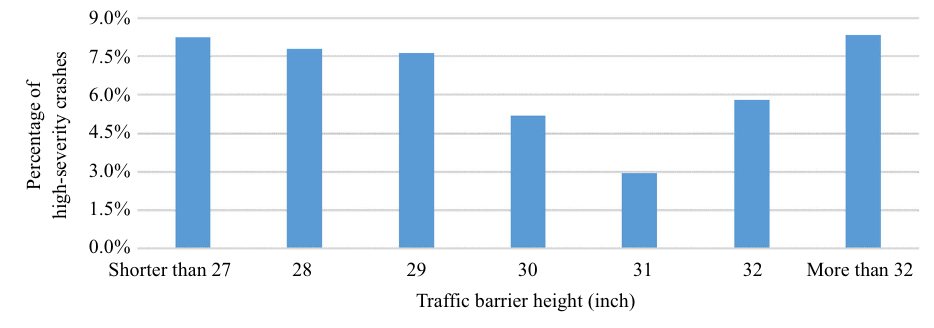
Fig. 4 Percentage of high-severity crashes in various categories of traffic barrier height